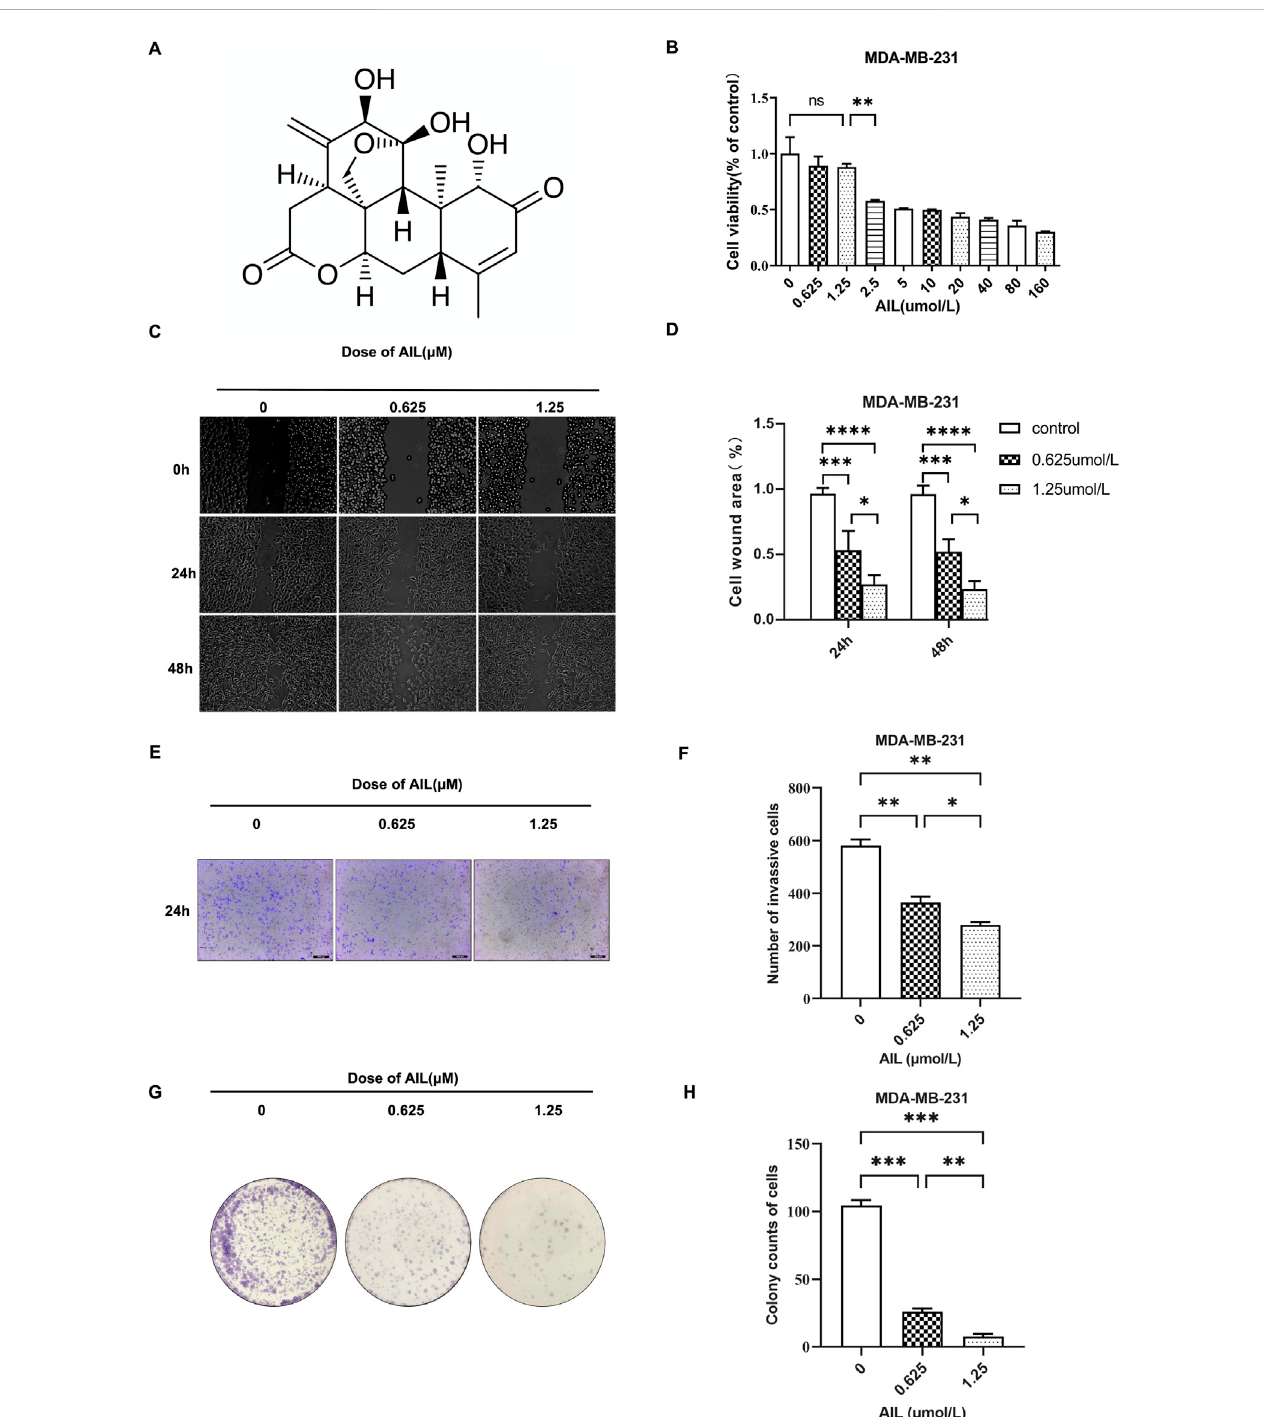
FIGURE 1 Non-toxic concentrations of AIL inhibit the migration, in fi ltration, and cloning capacity of the MDA-MB-231 cells, during the in vitro experiments. (A) Chemical structure of AIL. (B) Cytotoxicity of the MDA-MB-231 cells after being treated with varying AIL concentrations for 48 h. (C,D) Images presenting the migratory potential of MDA-MB-231 cells following 24 – 48 h of treatment using differing concentrations of AIL (100 × magni fi cation). The ImageJ software wasusedtocalculatethewoundhealingpercentage(%). (E,F) ImagesdepictingtheinvasivenessofMDA-MB-231cells24 haftertreatmentusingvarying AILconcentrations(100×magni fi cation).Cellsthatinvadedthebodywerecounted. (G,H) Awhole-holeimagedepictingthecapacityofMDA-MB-231cellsto form colonies after being exposed to varying concentrations of AIL. Cells that invaded the body were counted. The mean ± SD of the three replicates were used to express all the data. * p < 0.05, ** p < 0.01, *** p < 0.001, **** p < 0.0001 in comparison to the control